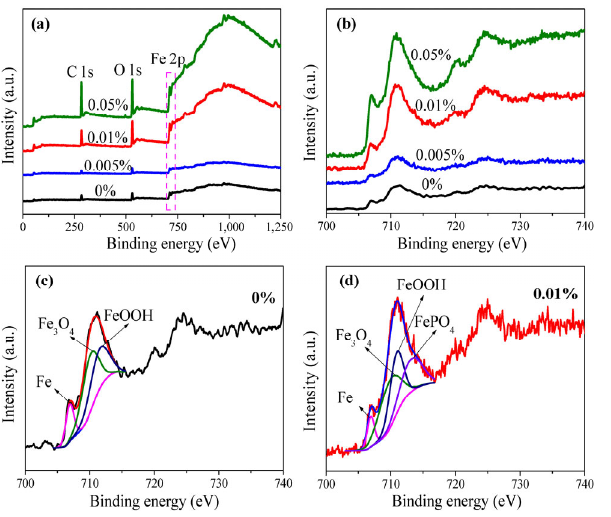
Fig. 15 XPS spectra of C 1s of the rubbed surfaces lubricated by PAO6 containing different mass concentrations of TiO 2 /BP nanocomposites under the load of 20 N: (a) 0%, (b) 0.005%, (c) 0.01%, and (d)